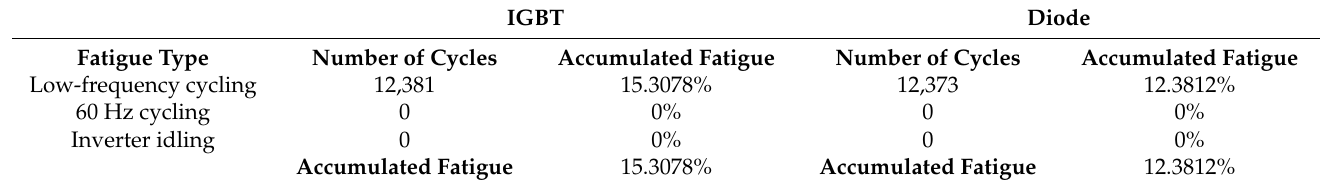
Table 16. Accumulated fatigue results from the two-year simulation with averaged thermal